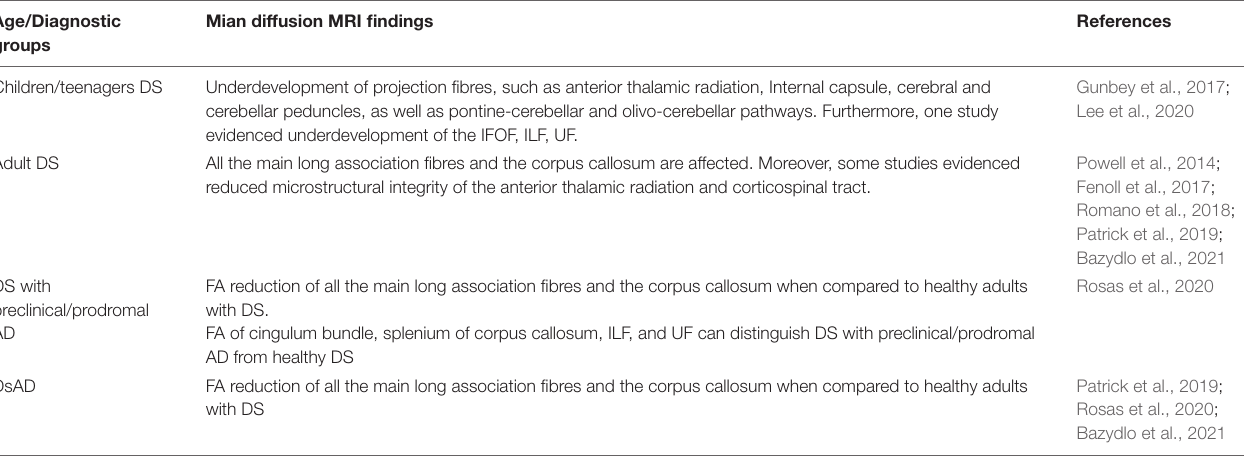
TABLE 3 | Main diffusion magnetic resonance imaging (MRI) findings in DS by age and diagnostic